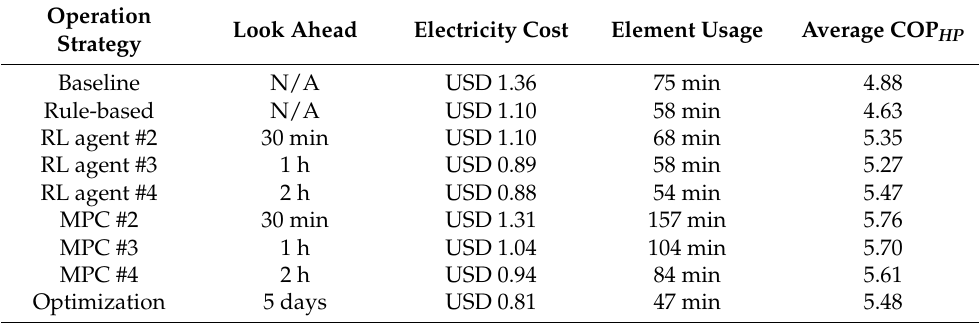
Figure 8. Operation based on RL agent #1. Table 6. Performance of RL agents, and MPC-based and optimization-based